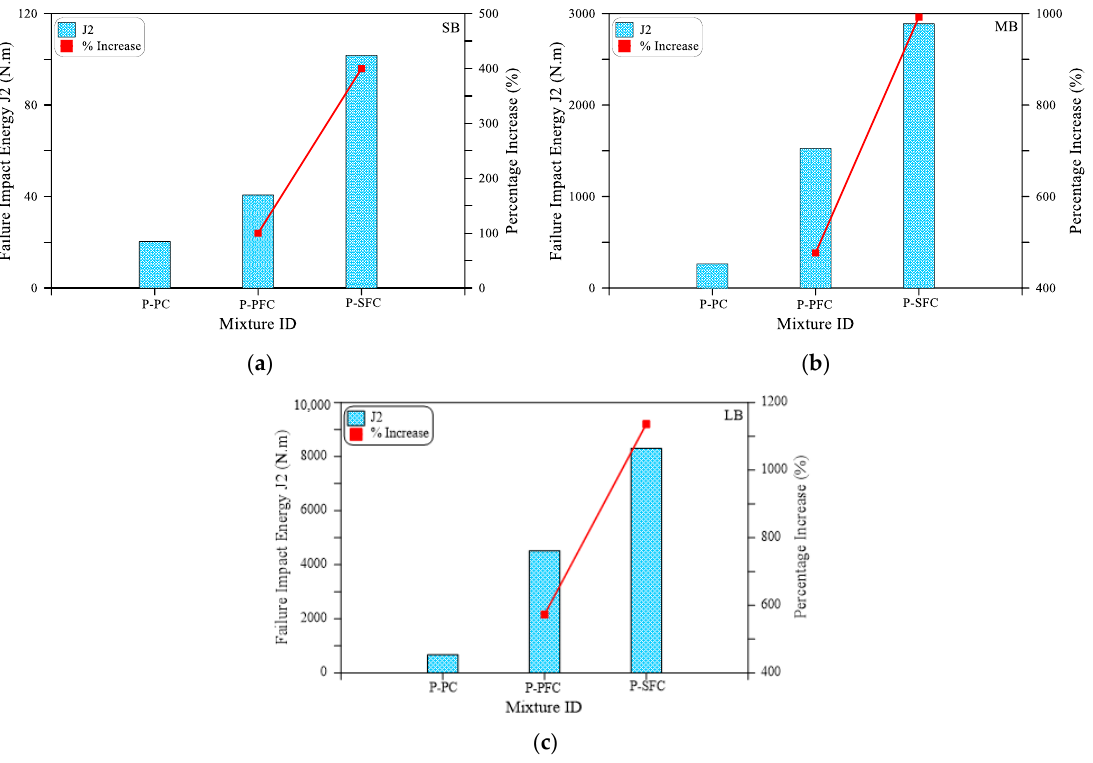
Figure 8. Failure impact energy (J2) of the three mixtures: ( a ) SB; ( b ) MB; ( c ) LB.